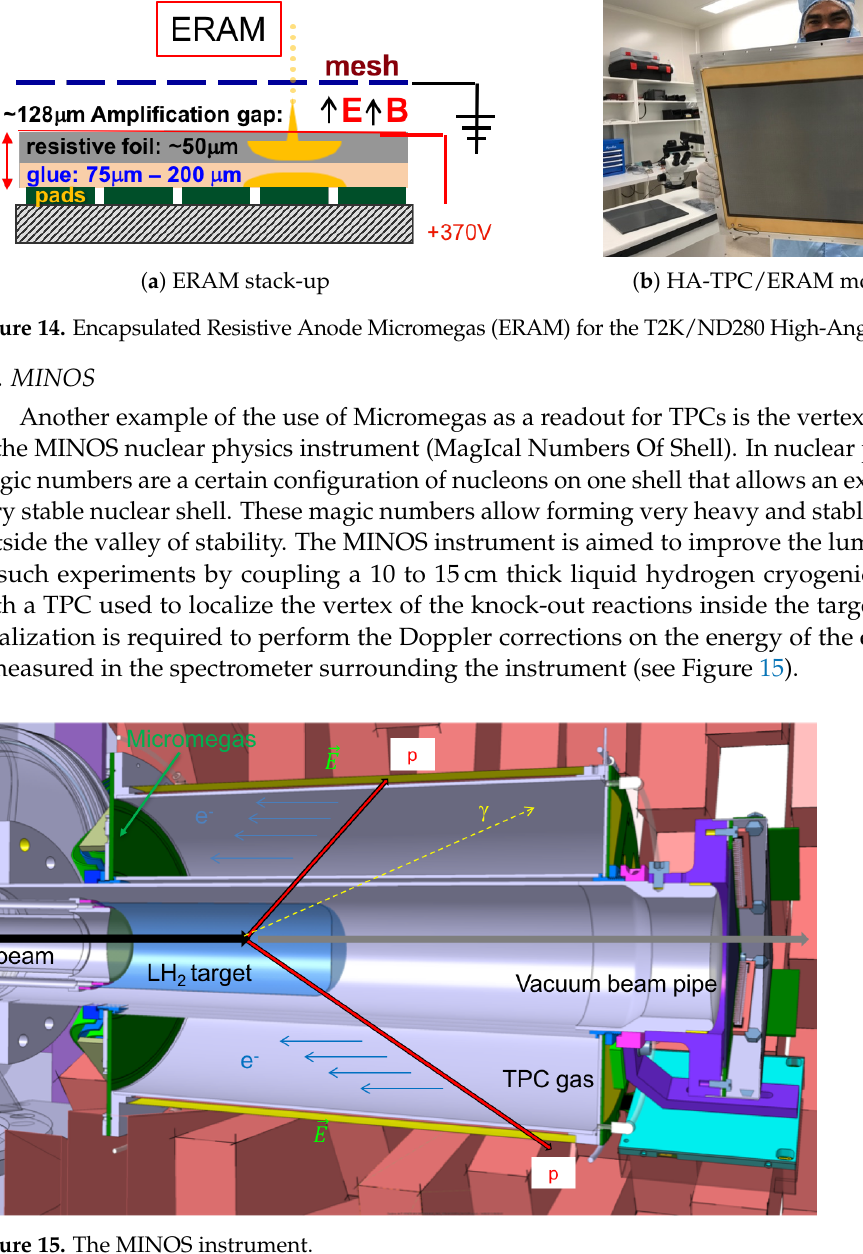
Figure 15. The MINOS